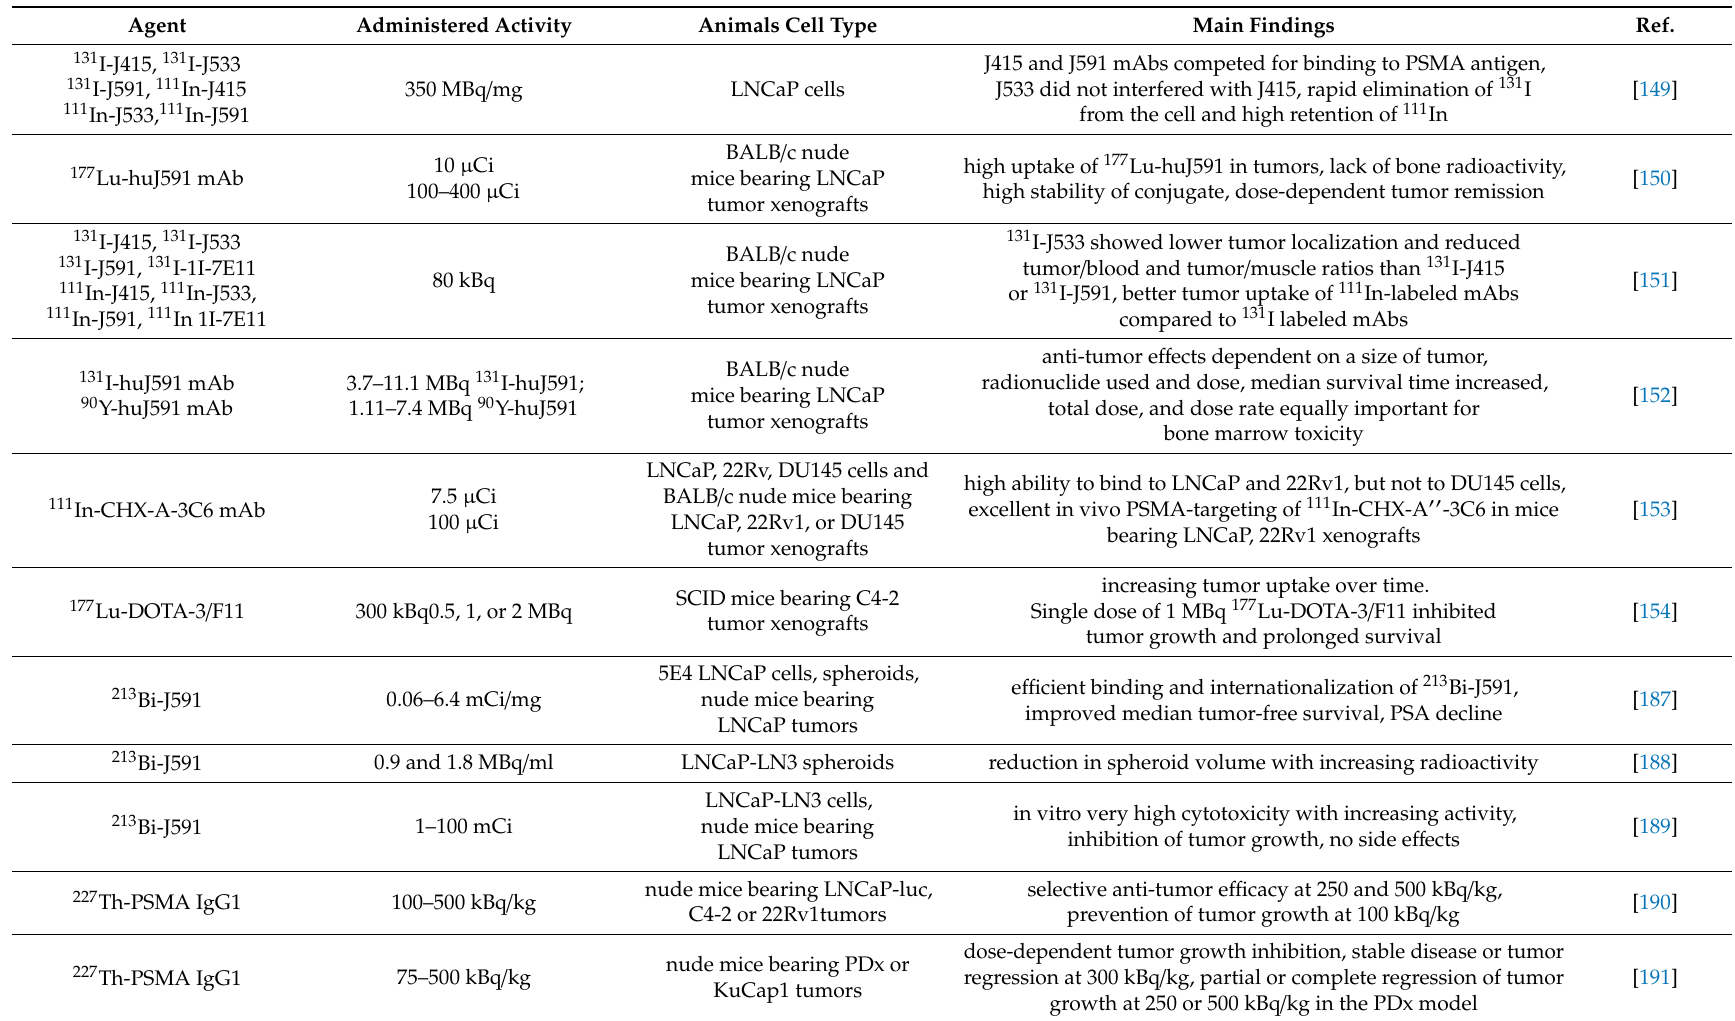
Table 2. Preclinical in vitro and in vivo studies of radiopharmaceuticals for targeted prostate cancer